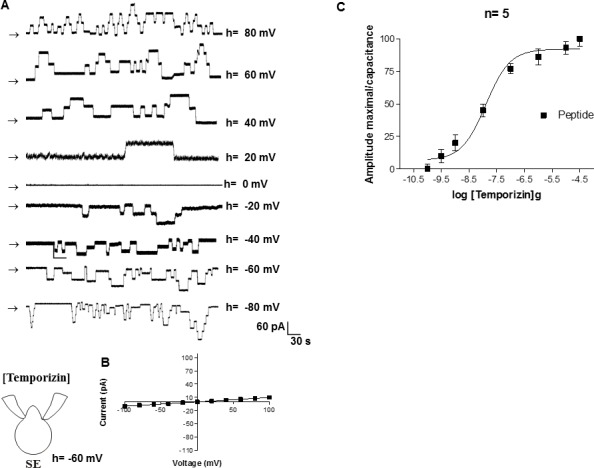
Temporizin induces a macroscopic ionic current in the HEK-293 mammalian cell line.A: Macroscopic ionic currents of a whole-cell patch from HEK-293 cells that were induced by different temporizin concentrations. The ionic currents (far right) elicited by temporizin are indicated by vertical arrows. The holding potential ranged from +100 mv to -100 mV. B: The mean I-V relations for the whole-cell configuration. C: Whole-cell recordings obtained from HEK-293 cells as a function of varied temporizin concentrations. The values represent the means ± SD of six experiments performed on different days.